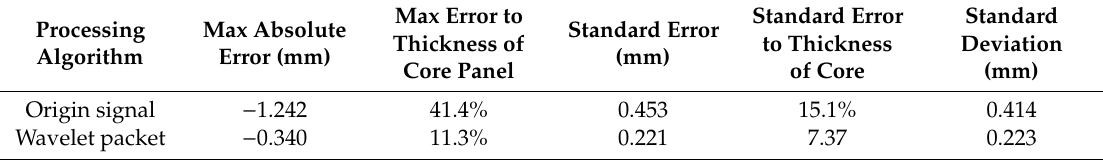
Table 6. Comparison of detection errors at 200 Hz sampling